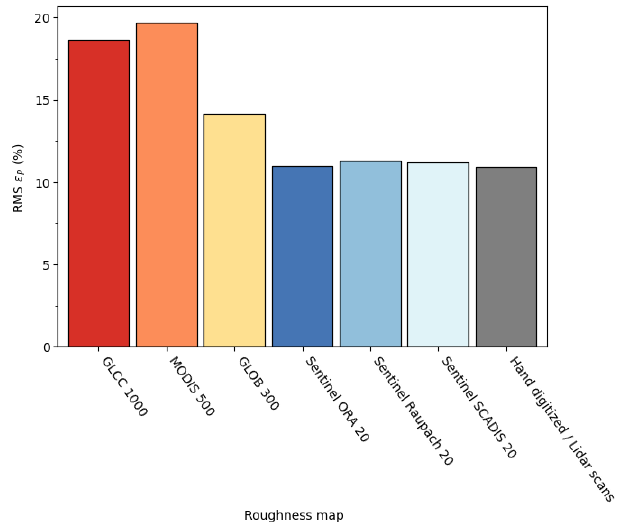
Figure 7. The RMSE in power density ( ε P , %) obtained when each available wind sensor is used to predict the power density at the location of other wind sensors located at the same site. Values are shown for all sites. Different colours refer to different roughness length maps used as input to the